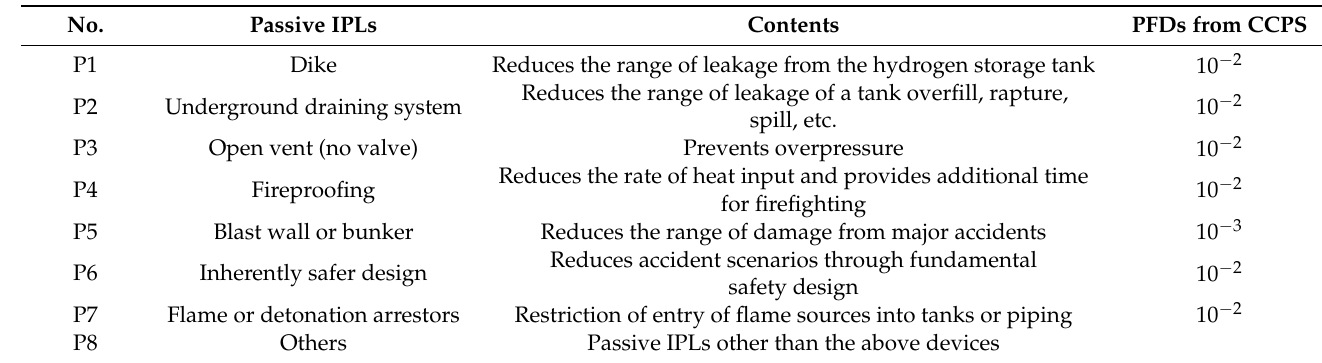
Table 4. PFDs (per year) for passive IPLs.